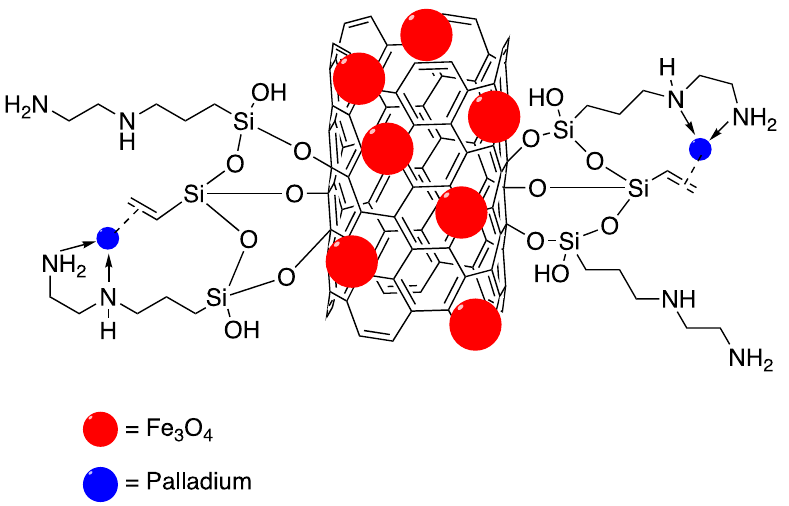
Figure 13. A graphical illustration of the CNT@Fe 3 O 4 @SiO 2 ‐ Pd catalyst [12] (Adapted with permission from Springer Nature).